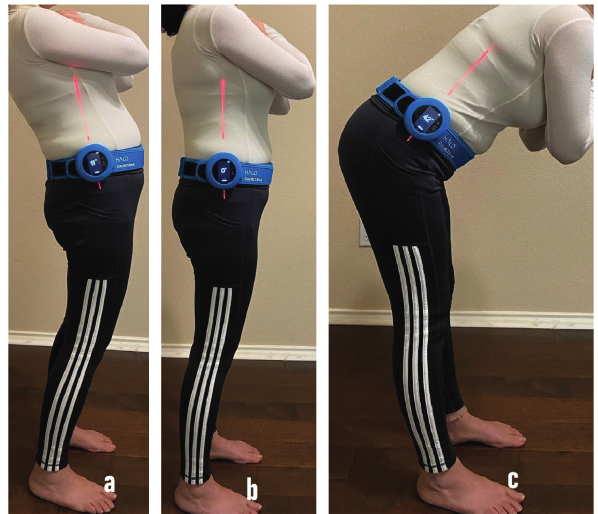
Figure 2: Measurement of the (a) trunk extension, (b) neutral, and (c) trunk flexion. A laser-guided digital goniometer (HALO) is fastened to a belt around the waist while